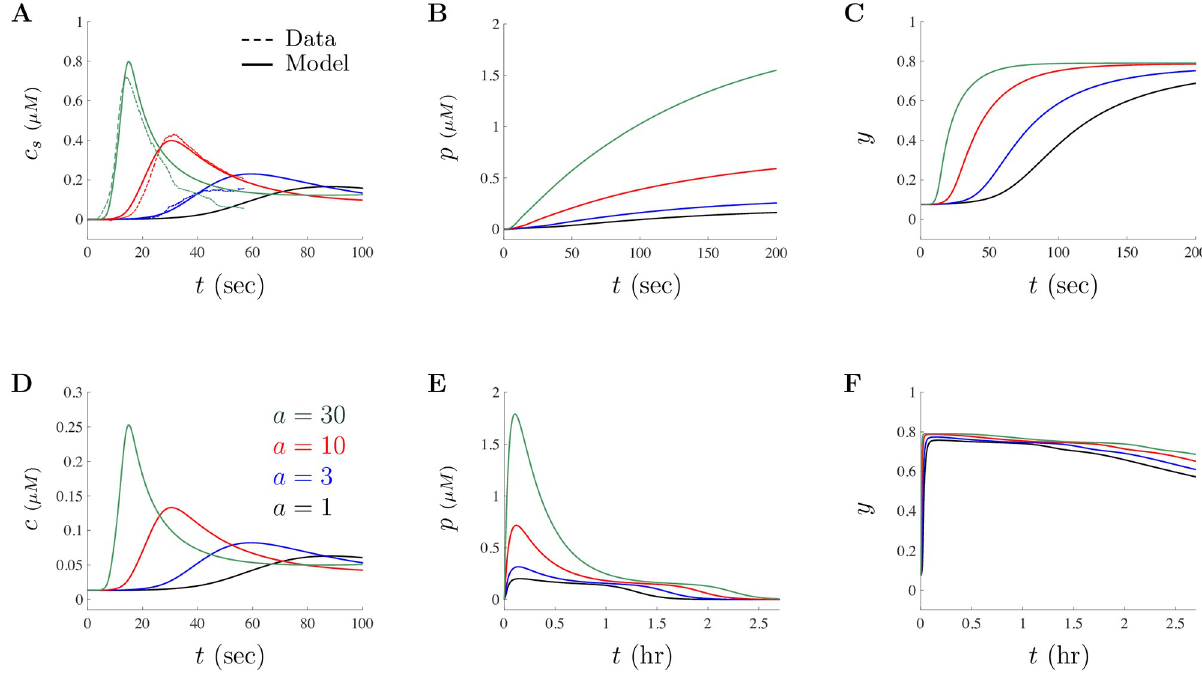
Fig 8. Model matches experimental data for large doses of A β . Model solutions for the “large” dose parameter set are illustrated in this figure. A shows model simulation (smooth curve) when a = 3 (blue), a = 10 (red), and a = 30 (green) overlaid on top of the rescaled experimental data (dashed curve) of [18]. Note that model solutions for the “large” dose parameters when a = 1 (black) is also shown here. B and C show the time evolution of model IP 3 and PLC, respectively. D shows the unscaled Ca 2+ concentration given by the model variable c for the three levels of A β and for a = 1 (black). E and F show the time evolution of p and y on the order of hours, respectively. Due to the A β decay incorporated in the model, all model solutions will eventually go back to the steady-state